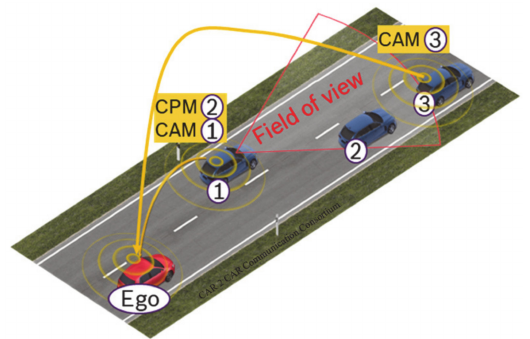
Figure 1. Example of detected vehicles with collective perception. Vehicles 1 and 3 data concerning their state in Cooperative Awareness Messages, while vehicle 1 also transmits vehicle 2 (cid:48) s data in Collective Perception Messages. The ego vehicle can then perceive all other vehicles (also including non-V2X equipped vehicles) [6].